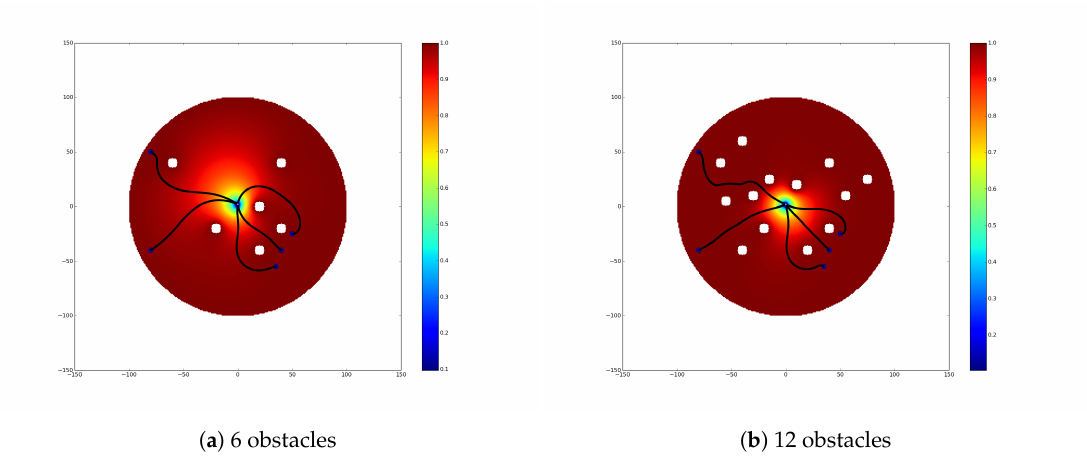
Figure 8. Navigation functions with trajectories from starting points 40 − 40 i , 35 − 55 i , 50 − 25 i , − 80 − 40 i and − 80 + 50 i